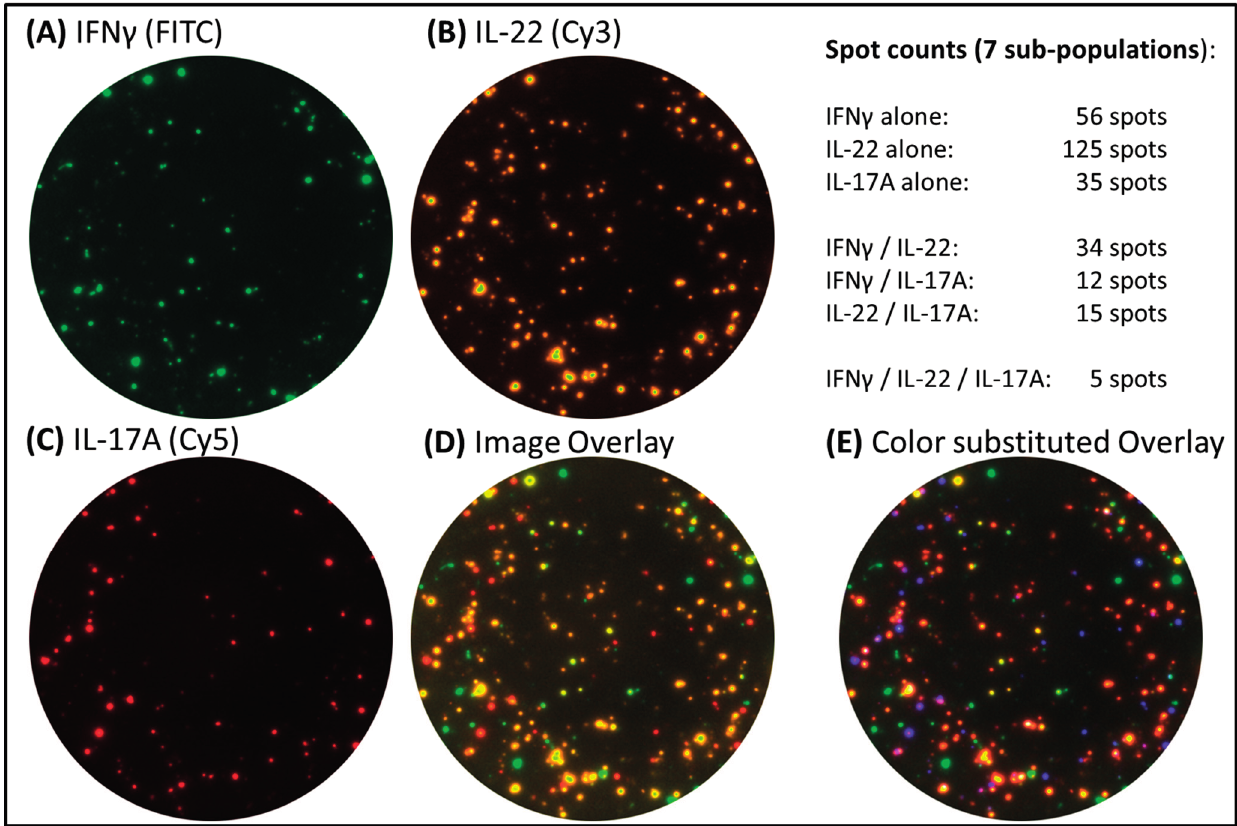
Figure 7. Triple cytokine FluoroSpot assay. PBMC were stimulated with Candida albicans extract and tested for IFN ɣ (FITC), IL-22 (Cy3) and IL-17A (Cy5) secretion. Level one images for separate fluorophores are depicted in panel ( A )–( C ). The level two image overlay and color substituted overlay for visualization purposes are shown in panel ( D ) and ( E ), respectively. The overall spot counts for all seven subpopulations are